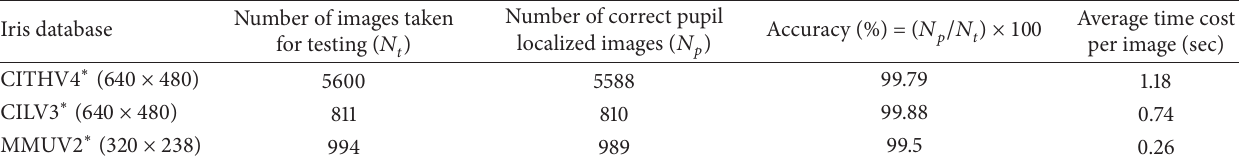
Table 1: Experimental results of the proposed pupil localization method.